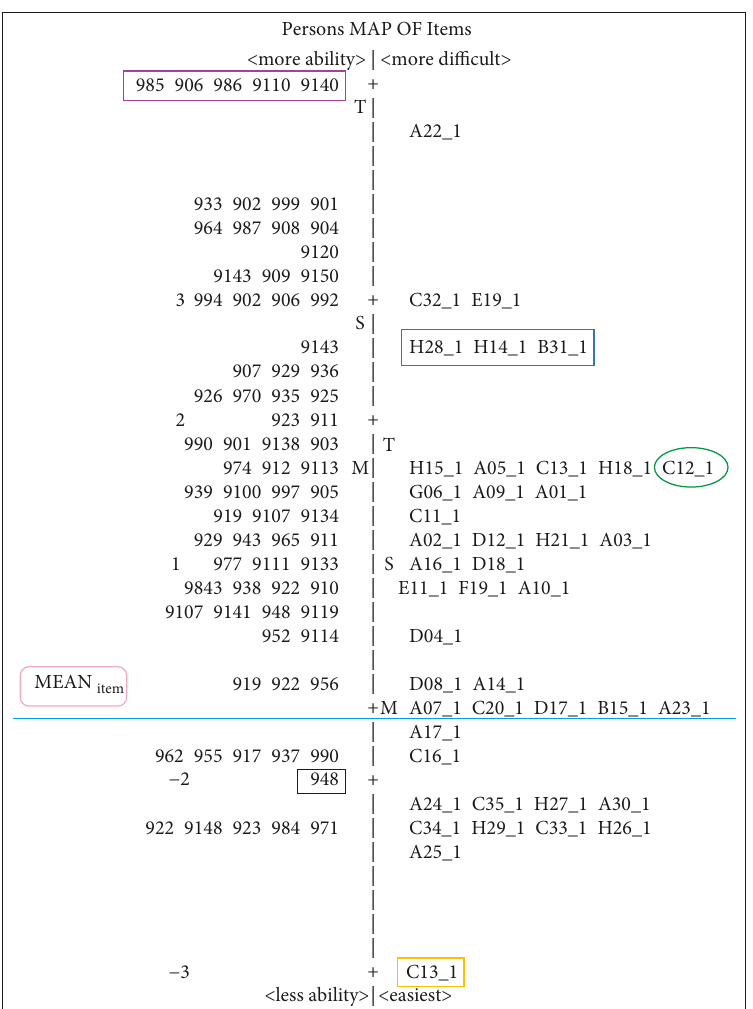
Figure 2: Wright